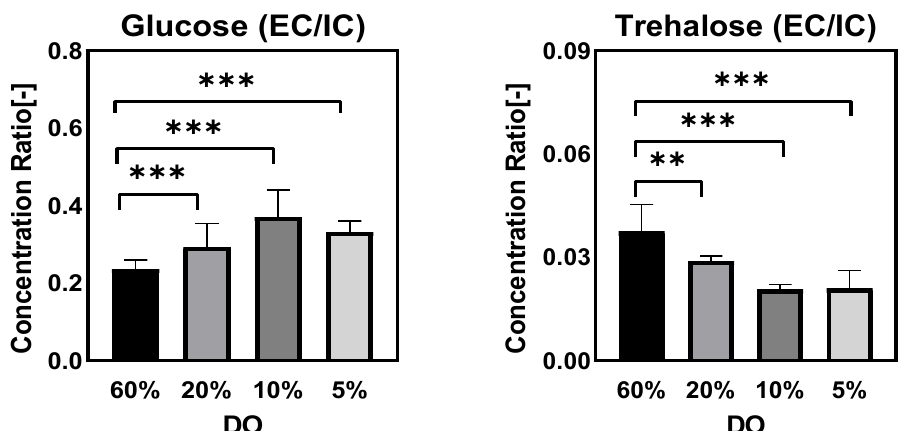
Figure 8. The ratio of extra/intracellular (EC/IC) trehalose and glucose concentrations (assuming a cellular volume of 2.5 mL/gDW) in Penicillium chrysogenum Wisconsin 54-1255 under steady-state dissolved oxygen (60%, 20%, 10%, and 5%) conditions. Samples were collected at 24 h intervals and data were collected from three replicate experiments. Two-tailed Student’s t -tests ((**) p < 0.01 and (***) p < 0.001) were performed using GraphPad Prism